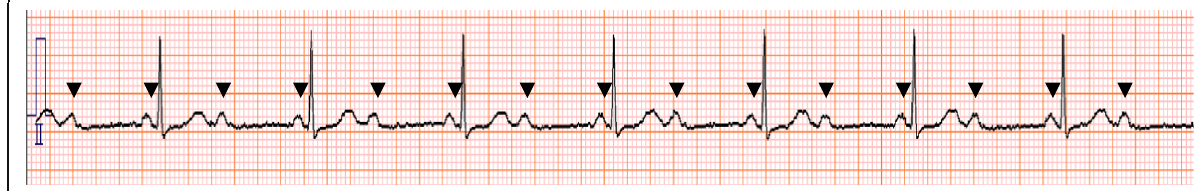
Fig. 1 Preoperative electrocardiogram. The tracing of lead II shows second-degree atrioventricular block with 2:1 AV conduction, ventricular rate of 46 beats per minute. Every other P wave ( marked ) was regularly conducted. Note the short PR interval during conducted complexes and the narrow QRS